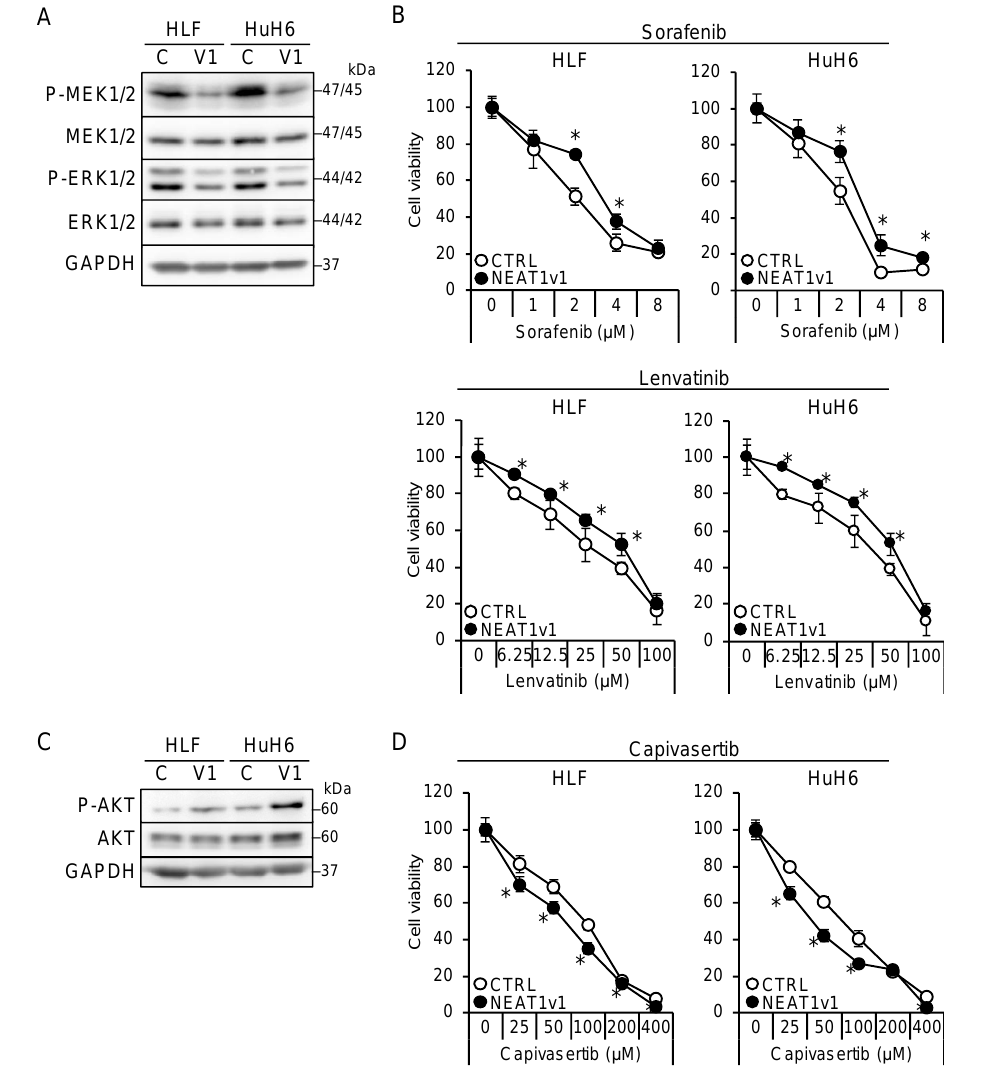
Figure 3. NEAT1v1 plays a role as a molecular switch of cell growth modality. ( A , C ) Representative Western blot images for the indicated proteins in control ( C ) or NEAT1v1-overexpressing (V1) cells. GAPDH is shown as an internal control. ( B , D ) Viabilities of control (CTRL) or NEAT1v1-overexpressing (NEAT1v1) cells treated with sorafenib ( B ), lenvatinib ( B ), or capivasertib ( D ) at the concentrations indicated in the figure for 48 h relative to cells treated with DMSO (100%). * p < 0.05 vs. CTRL (Student’s t -test; n = 4).